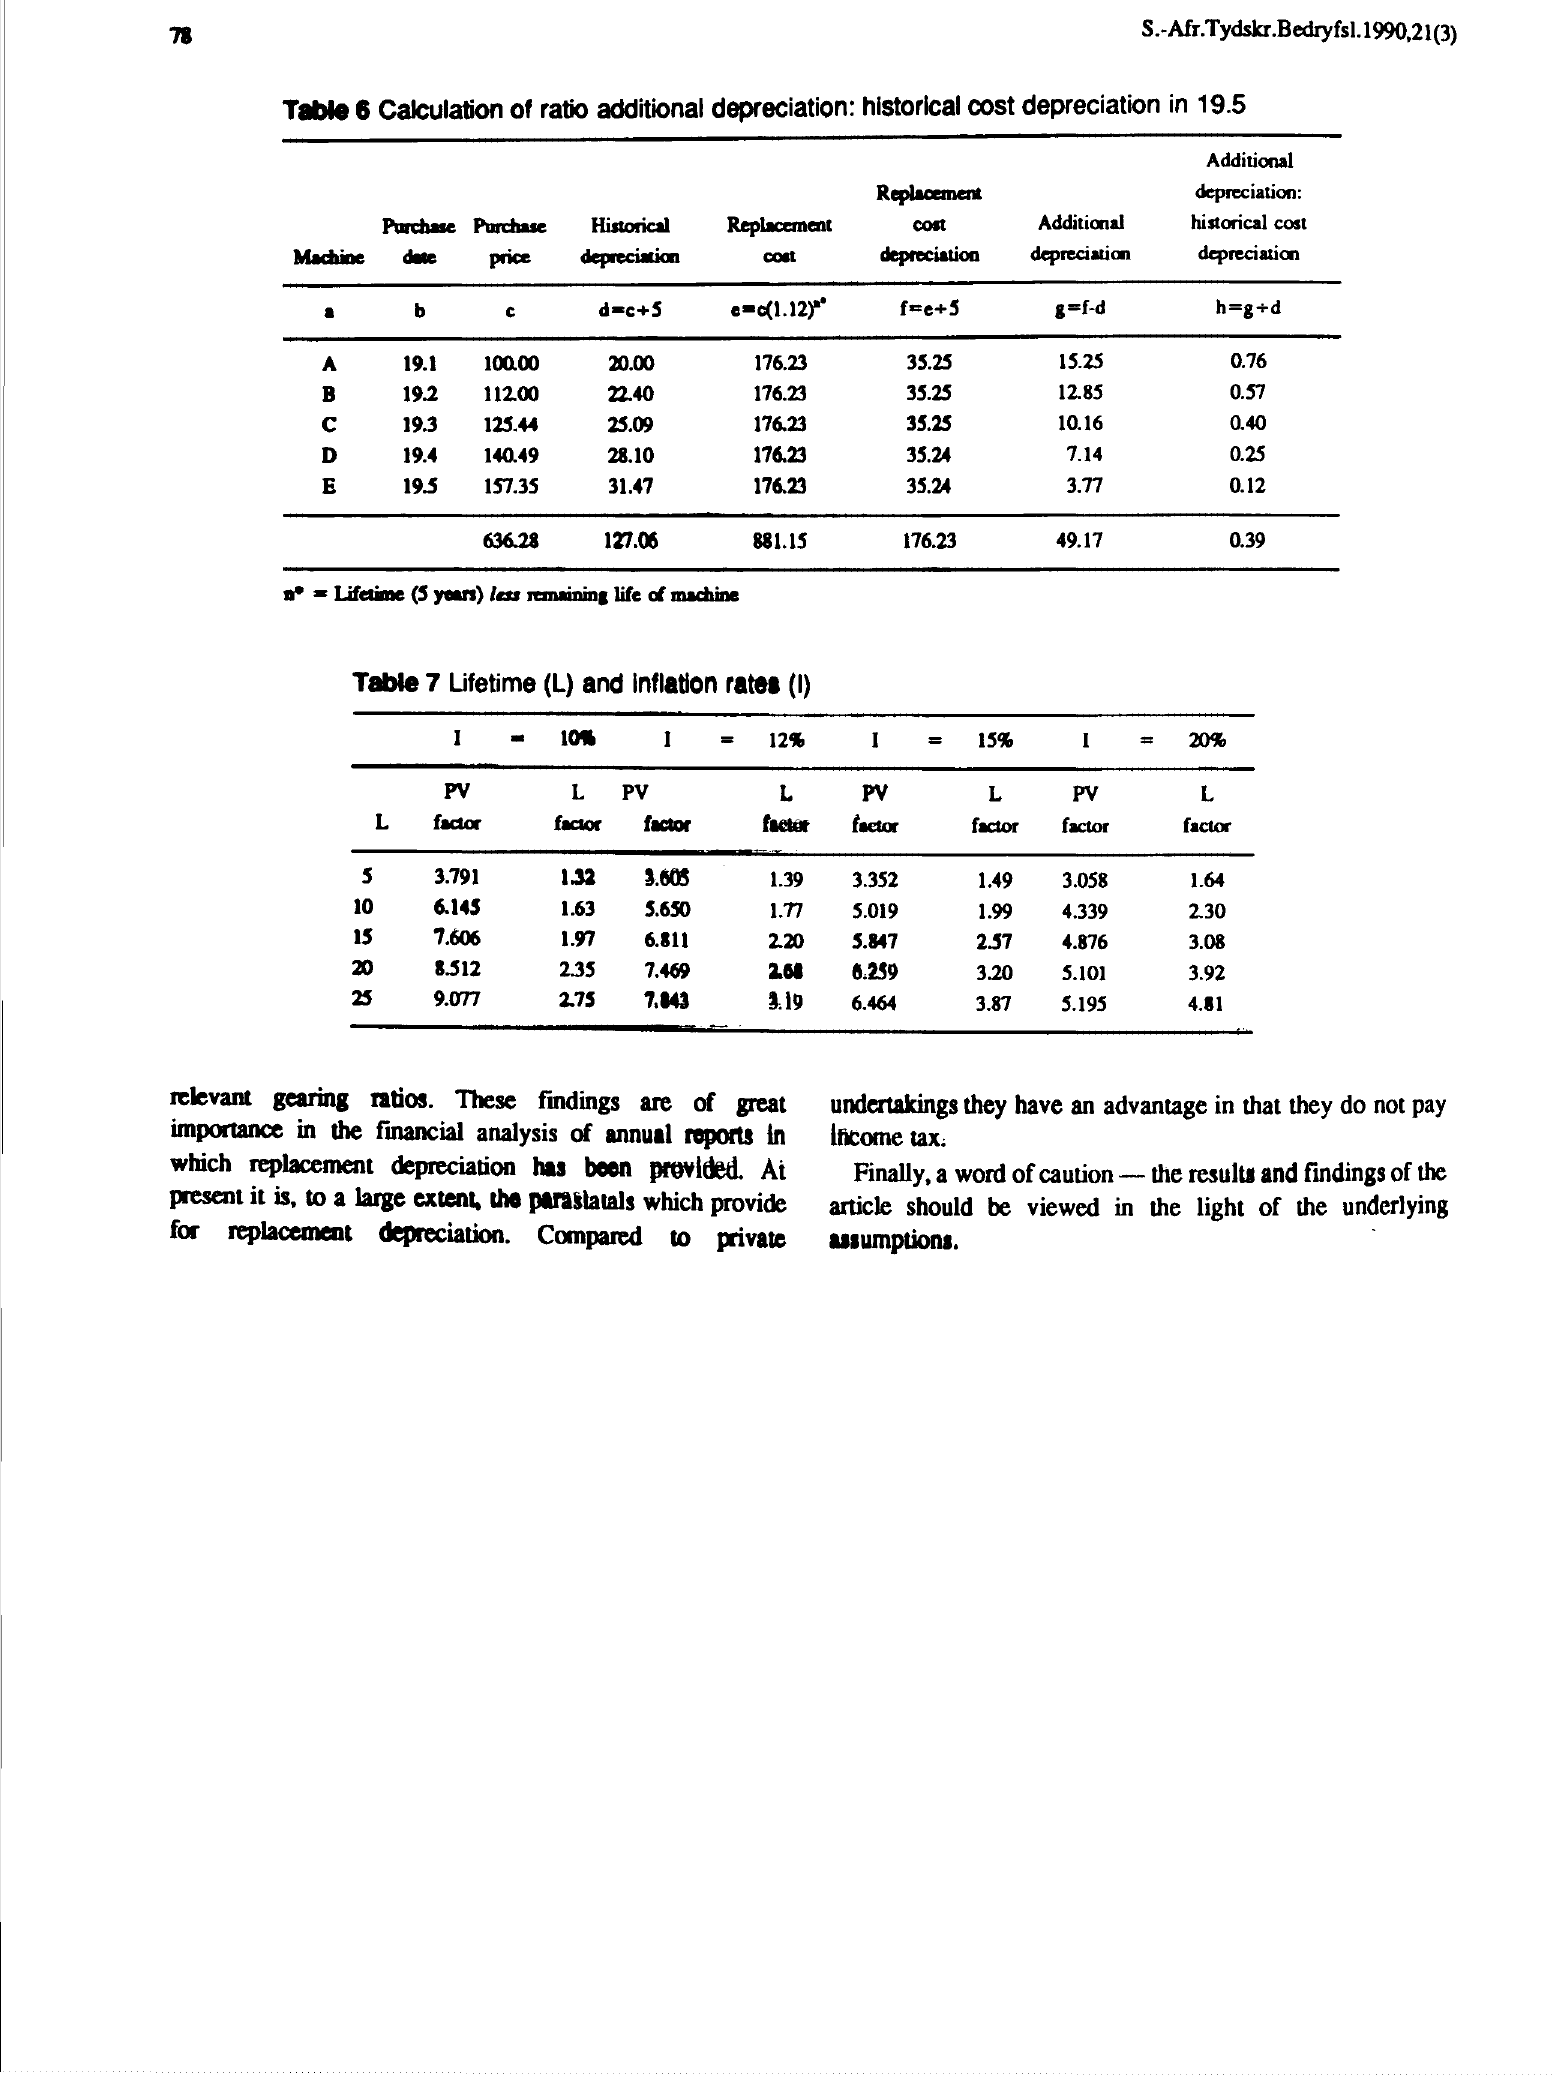
Table 7 Lifetime (L) and Inflation rate1 (I)